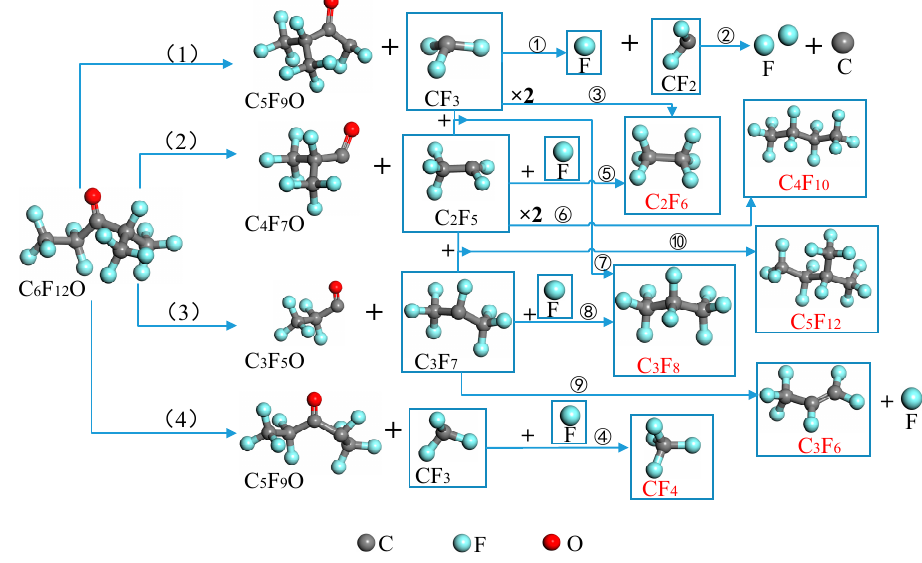
Figure 7. Schematic of the decomposition process.